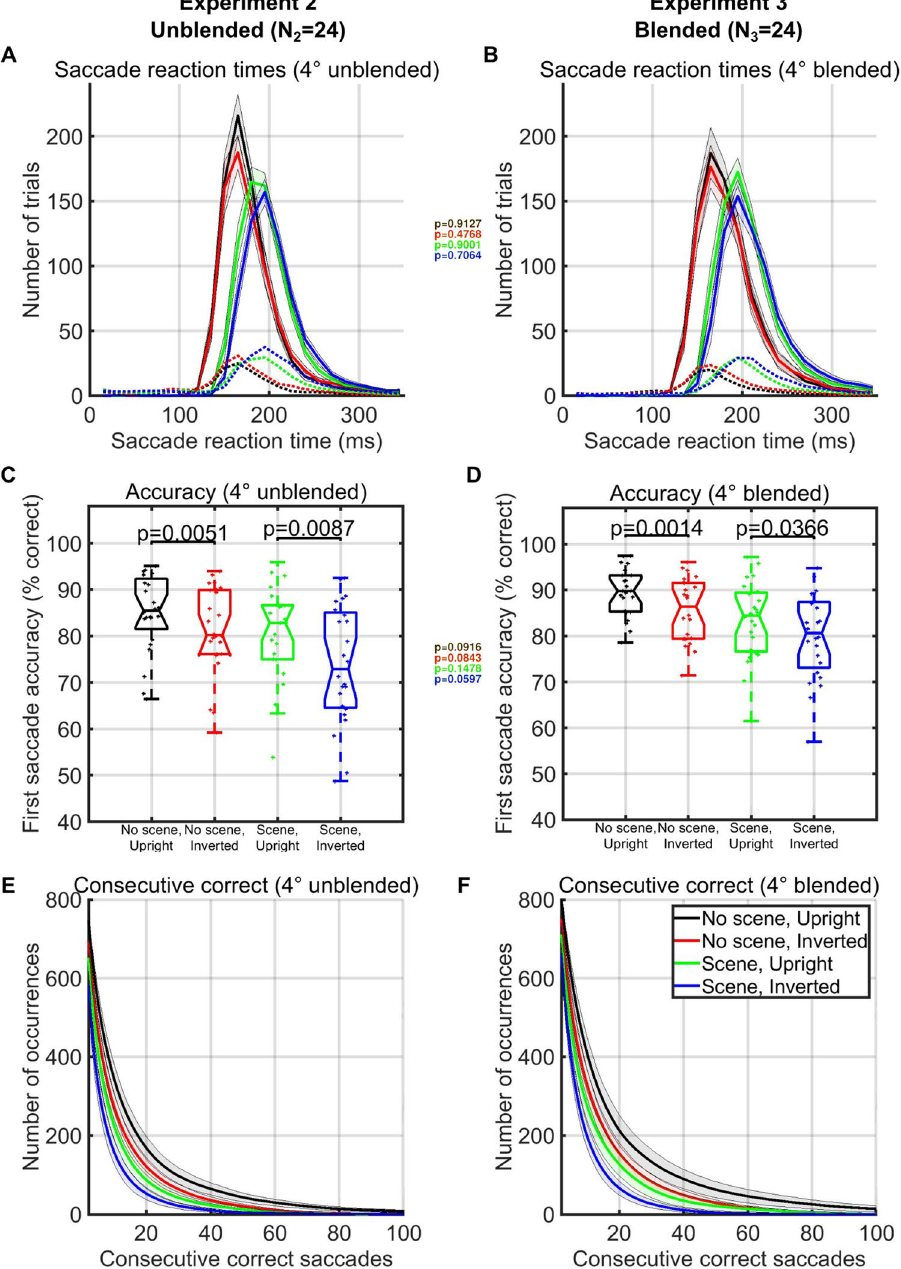
Figure 4. Saccade reaction time and first saccade accuracy comparisons for Experiment 2 and 3 (limited eccentricities and polar angles–see Fig. 3A, inset). ( A , B ) Saccade reaction time histograms for all trials and all subjects (( A) : unblended, Experiment 2, ( B ): blended, Experiment 3). Solid lines represent correct trials and dotted lines represent incorrect trials. Each color represents a different stimulus condition (see legend). Text inset with colored p-values shows the statistical comparisons for each color-coded condition between mean subject SRTs for Experiment 2 and mean subject SRTs for Experiment 3 using only the 17 subjects that only did one experiment (Wilcoxon ranksum test). ( C , D ) Accuracy of the first saccade for each condition as defined by whether or not the first saccade after stimulus onset landed within a 3° × 3° square surrounding the face. Text inset of colored p-values shows the statistical comparisons for each color-coded condition between Experiment 2 and Experiment 3 using only the 17 subjects that only did one experiment (Wilcoxon ranksum test). ( E , F ) Number of occurrences of each particular length of consecutive correct saccades for each condition (x-axis). Shaded areas represent the standard error of the subject mean at each location for each